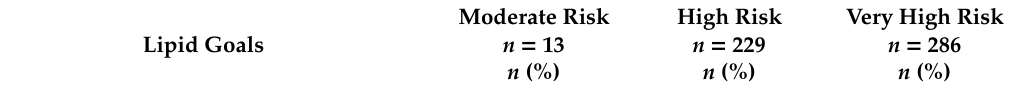
Table 5. Proportion of patients that achieved lipid goals in the simulation analysis (ideal scenario where everyone received appropriate doses of statins ±